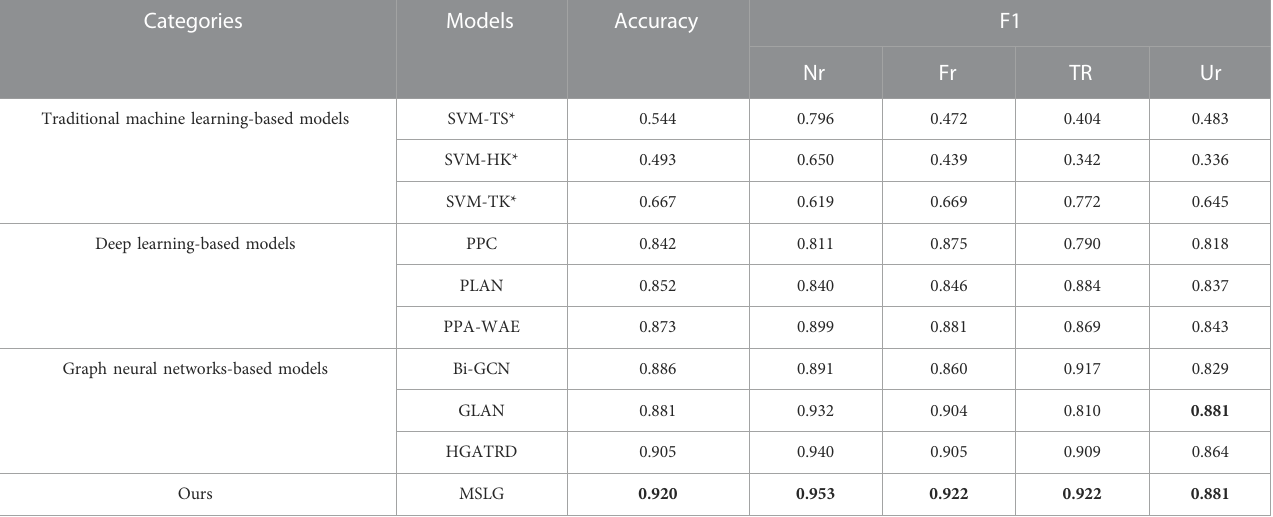
TABLE 3 Performance on Twitter15 dataset. The results indicated with * are obtained from [14] (NR: Non-Rumor; FR: False Rumor; TR: True Rumor; UR: Unveri fi ed Rumor).